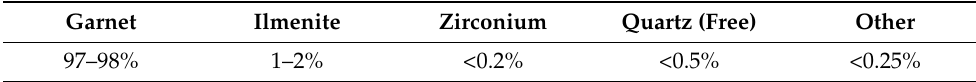
Table 6. Mineral composition of the original abrasive material according to the supplier’s list.